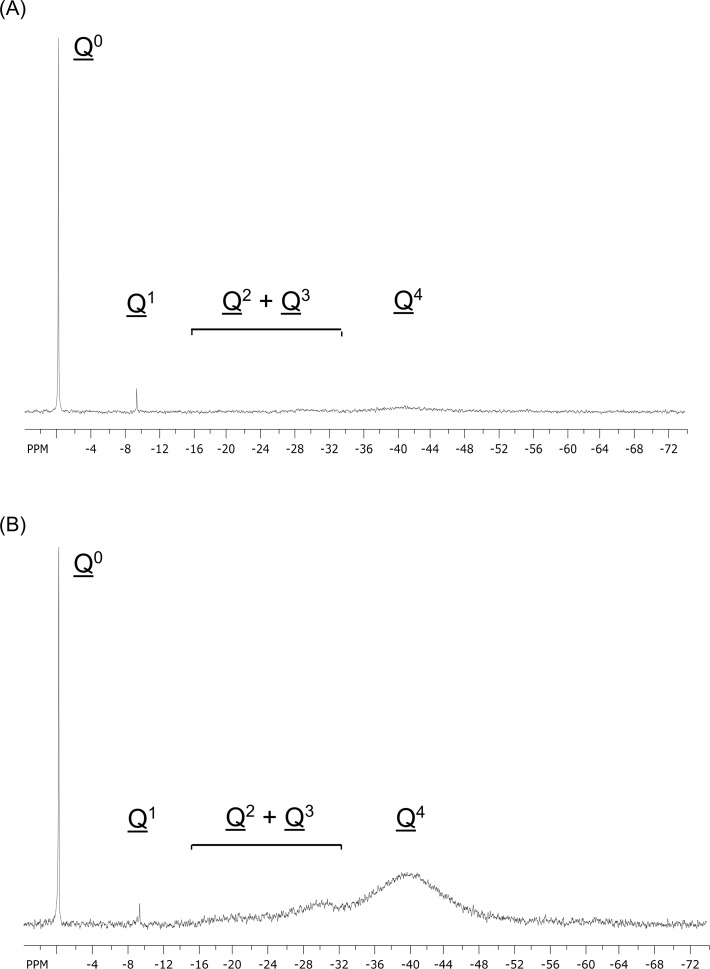
29Si NMR spectra (99.35 MHz) at 25°C of a) 6 and b) 42 mM silica dispersions.Qn represents a Si atom with n coordinated -OSi groups.